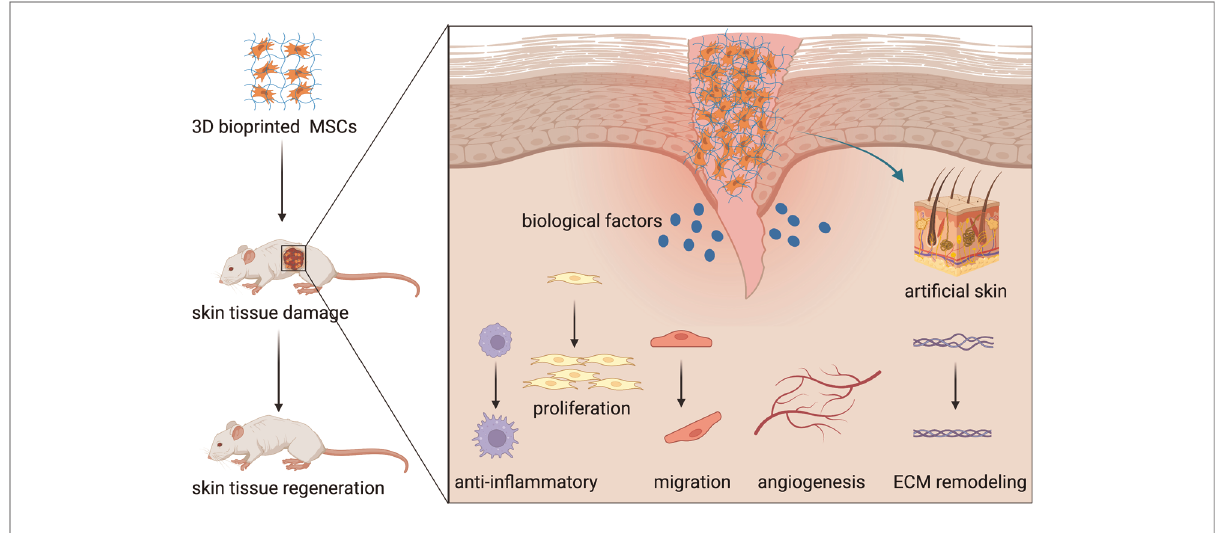
FIGURE 3 3D-bioprinted MSCs promote skin tissue regeneration. MSCs, mesenchymal stromal